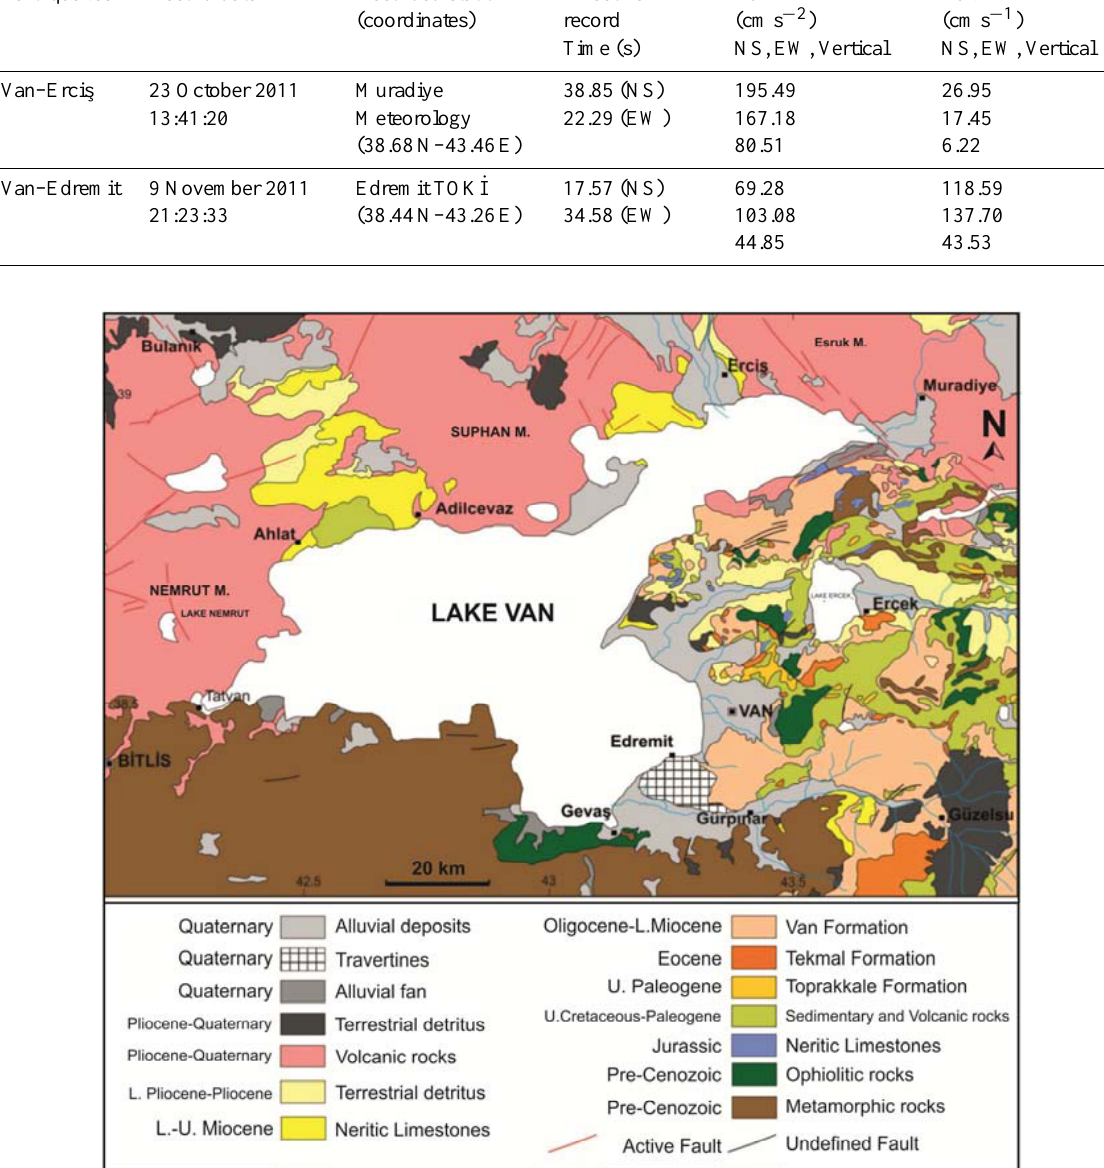
Fig. 2. Geological map of Lake Van and the surrounding area (MTA, 2002).